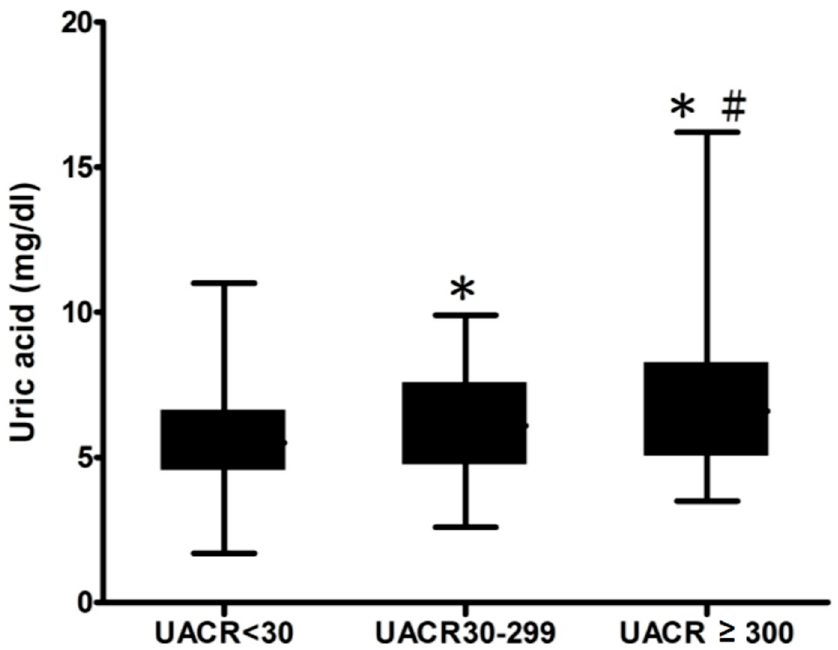
Figure 1. Serum uric acid (SUA) concentrations in urinary albumin-to-creatinine ratio (UACR) < 30, UACR 30–299, and UACR ≥ 300 groups. UACR < 30 group, n = 232, SUA = 5.6 ± 1.6 mg/dL; UACR 30–299 group, n = 100, SUA = 6.1 ± 1.7 mg/dL; UACR ≥ 300 group, n = 53, SUA = 6.9 ± 2.3 mg/dL. * p < 0.001, UACR 30–299 group versus UACR < 30 group; UACR ≥ 300 group versus UACR 30–299 group. # p < 0.001, UACR ě 300 group versus UACR < 30